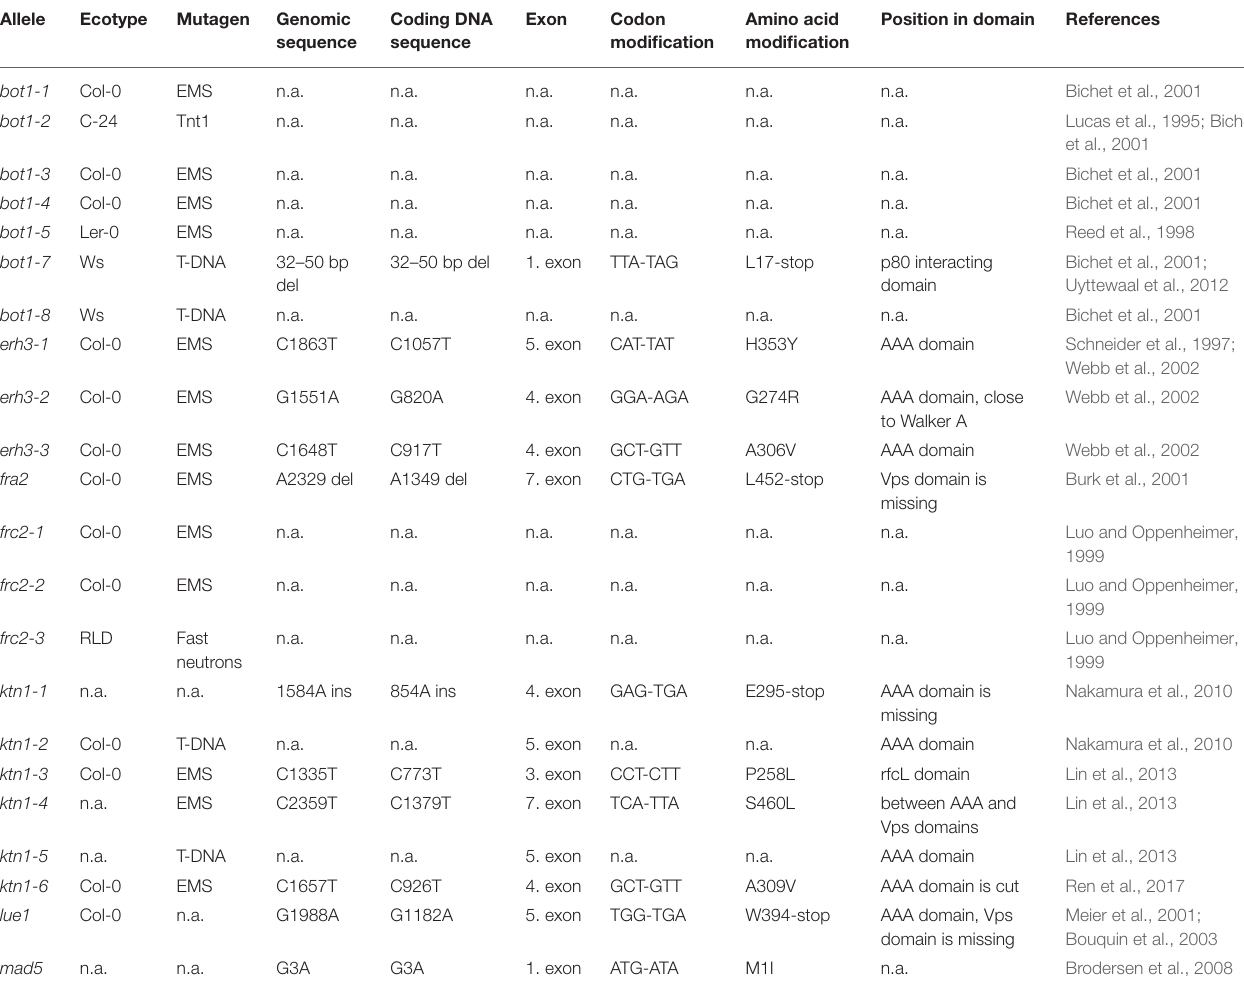
TABLE 1 | Genetic characteristics of Arabidopsis KATANIN mutants and in silico prediction of modifications in amino acid sequences.